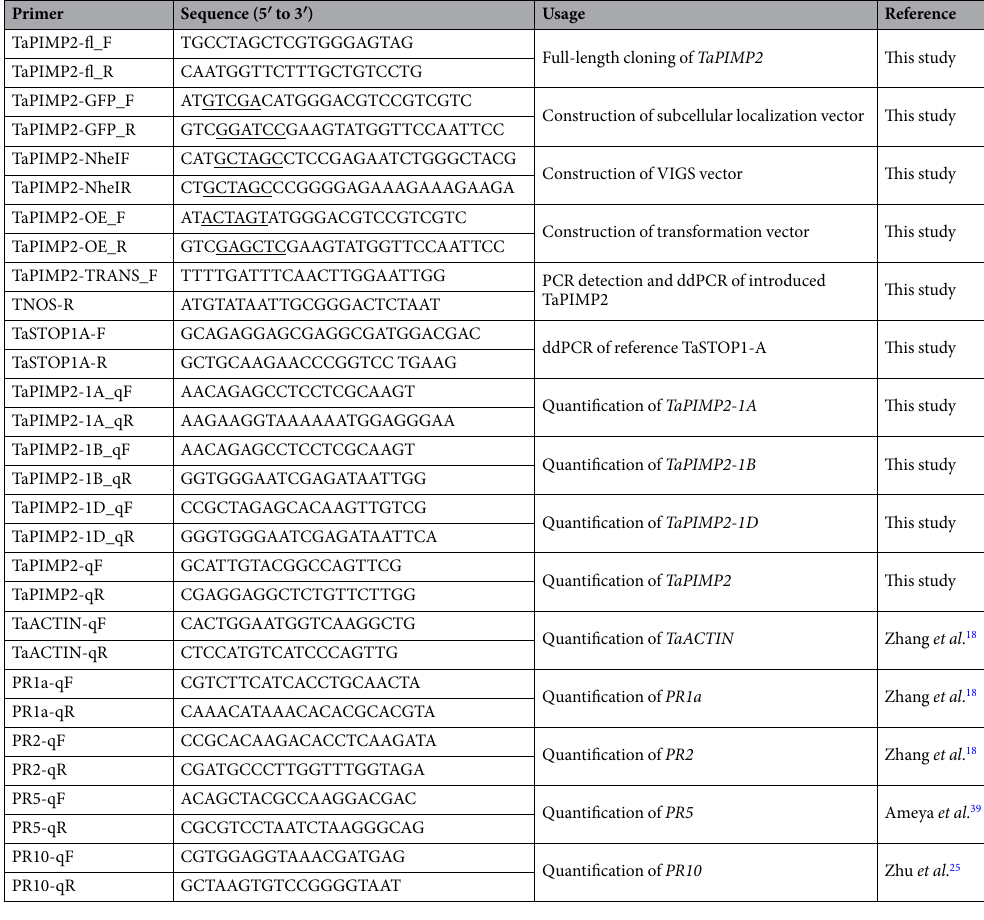
Table 1. The primers used in this